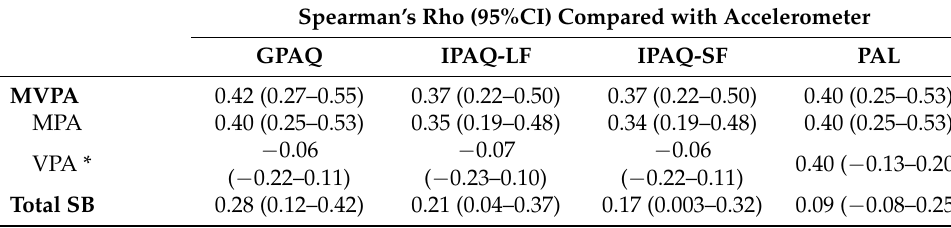
Table 4. Concurrent validity data of the GPAQ, IPAQ-LF, IPAQ-SF and PAL ( n = 141).